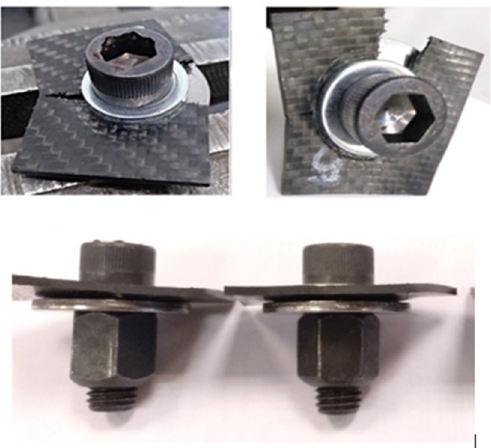
Figure 7. Specimens PA66-CF45 after failure. ( Left ) Crack to 124 Nm without deformation. ( Right ) Fracture to 146 Nm with minimal